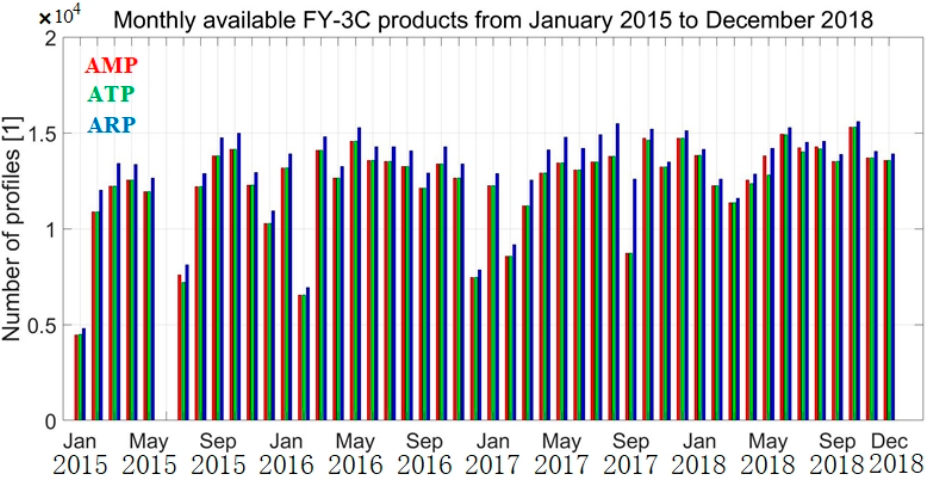
Figure 1. Monthly available FY-3C AMP, ATP and ARP products from January 2015 to December 2018.